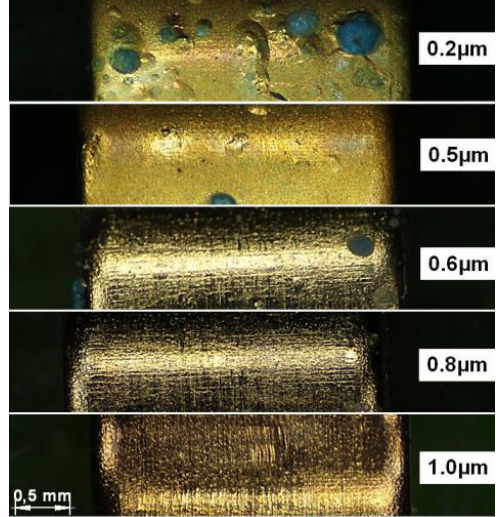
Figure 14. Gold coating with a thickness of 0.2–1.0 µm after exposure to nitric vapor for 75 min. at 60